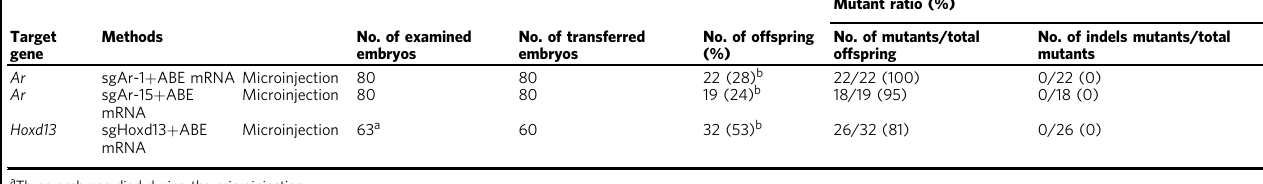
Table 1 Summary of the manipulation and genotyping of newborn